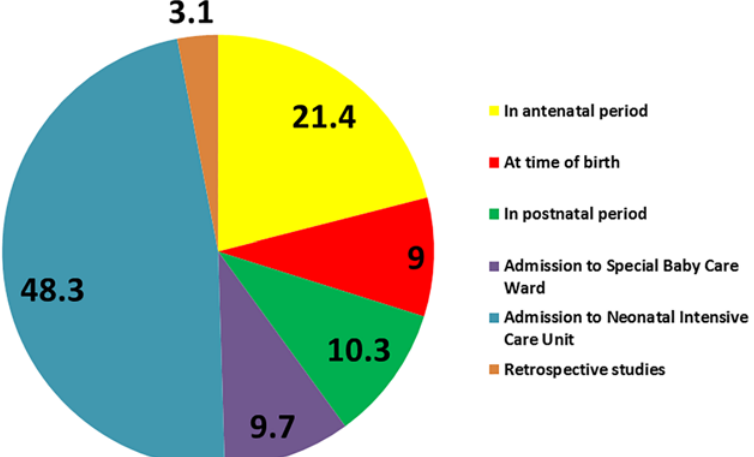
Fig 3. Setting and timing of recruitment for studies reporting on outcome of preterm birth in low and middle income settings (%